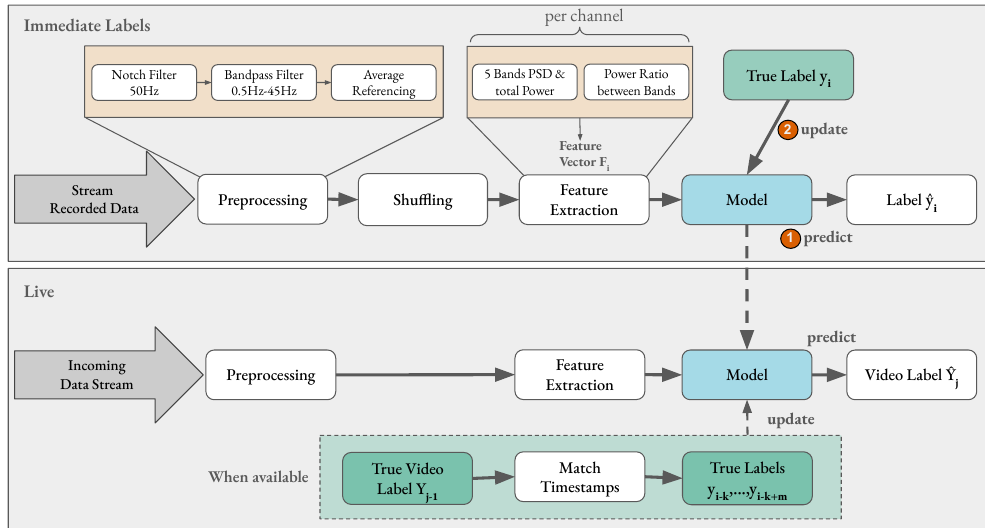
Figure 6. Overview of pipeline steps for affect classification. The top gray rectangle shows the pipeline steps employed in an immediate label setting with prerecorded data. For each extracted feature vector the model (1) first classifies its label before (2) being updated with the true label for that sample. In the live setting, the model is not updated after every prediction, as the true label of a video only becomes available after the stimulus has ended. The timestamp of the video is matched to the samples’ timestamps to find all samples that fall into the corresponding time frame and update the model with their true labels (shown in dotted